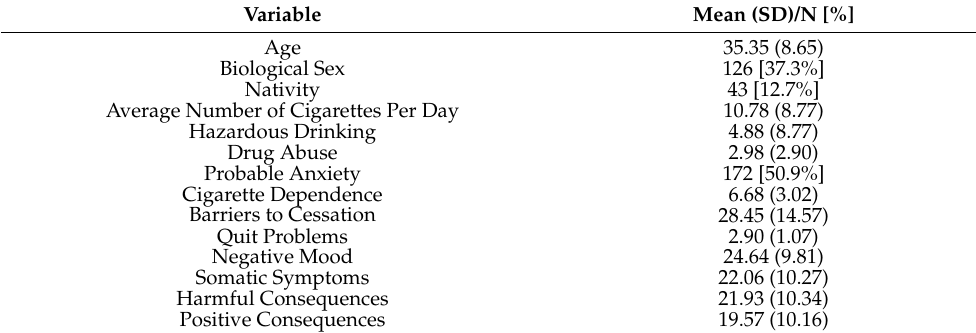
Table 1. Descriptive